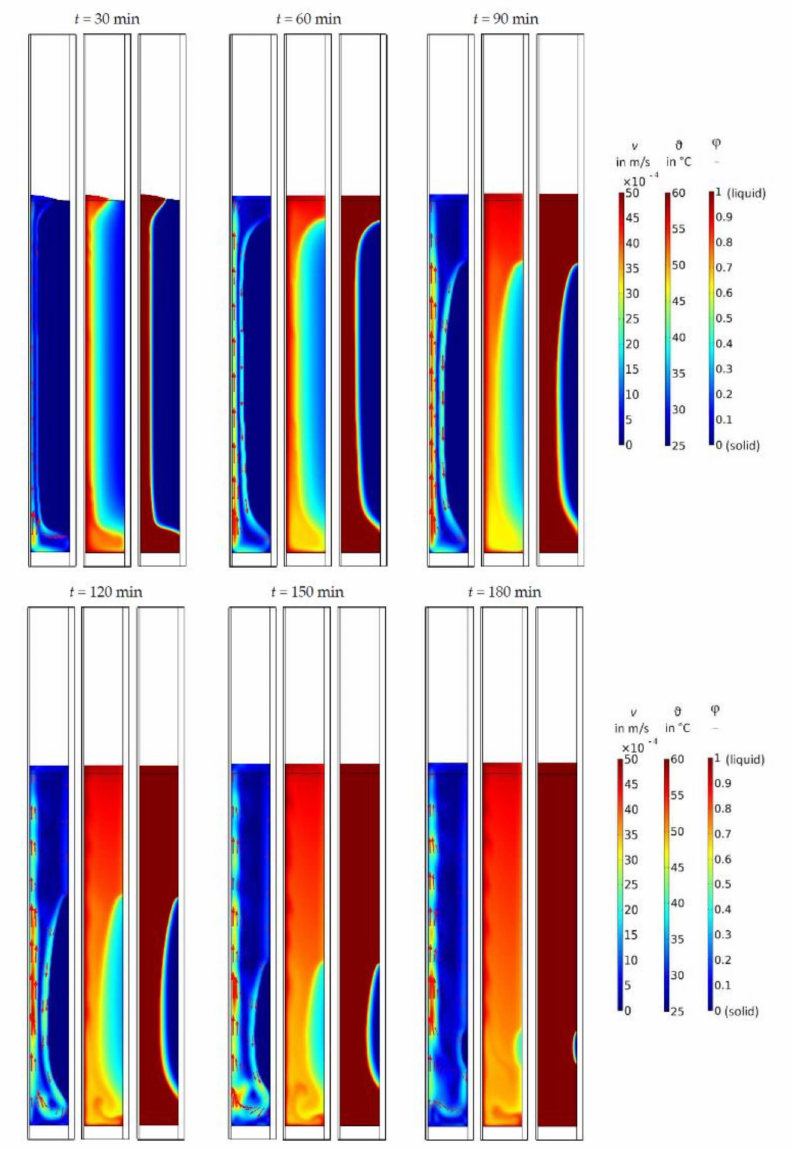
Figure 5. Numerical results of the enhanced model for the PCM-domain: Velocity v ( left ), temperature ϑ ( center ), and melting fraction ϕ ( right